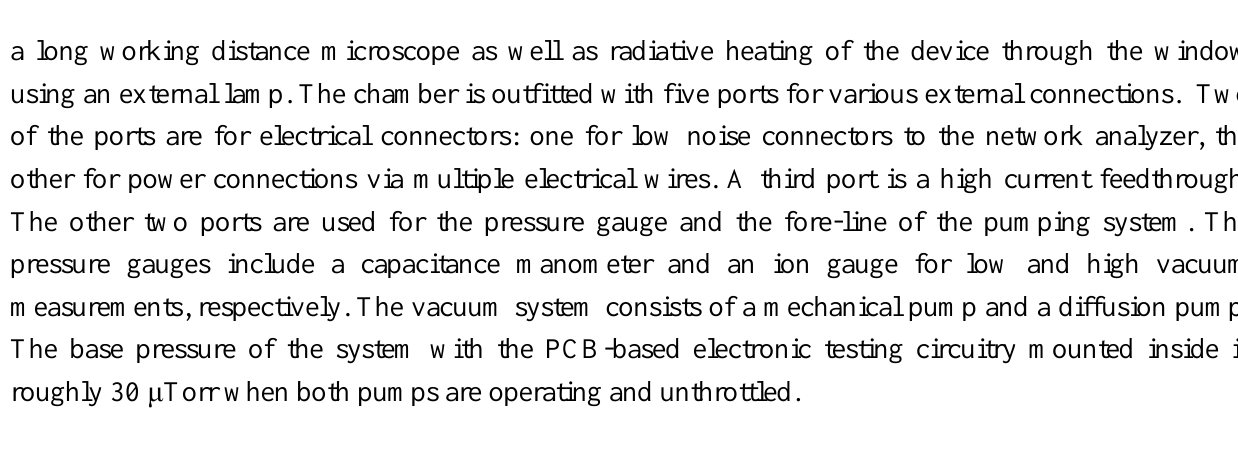
Figure 1. Plan-view SEM micrograph of a polycrystalline 3C-SiC, flexural mode lateral resonator Device D 1 . f